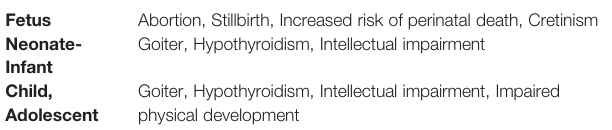
TABLE 5 | Clinical manifestations of iodine-de fi ciency disorder; adapted from reference (2). Fetus Abortion, Stillbirth, Increased risk of perinatal death, Cretinism Neonate- Infant